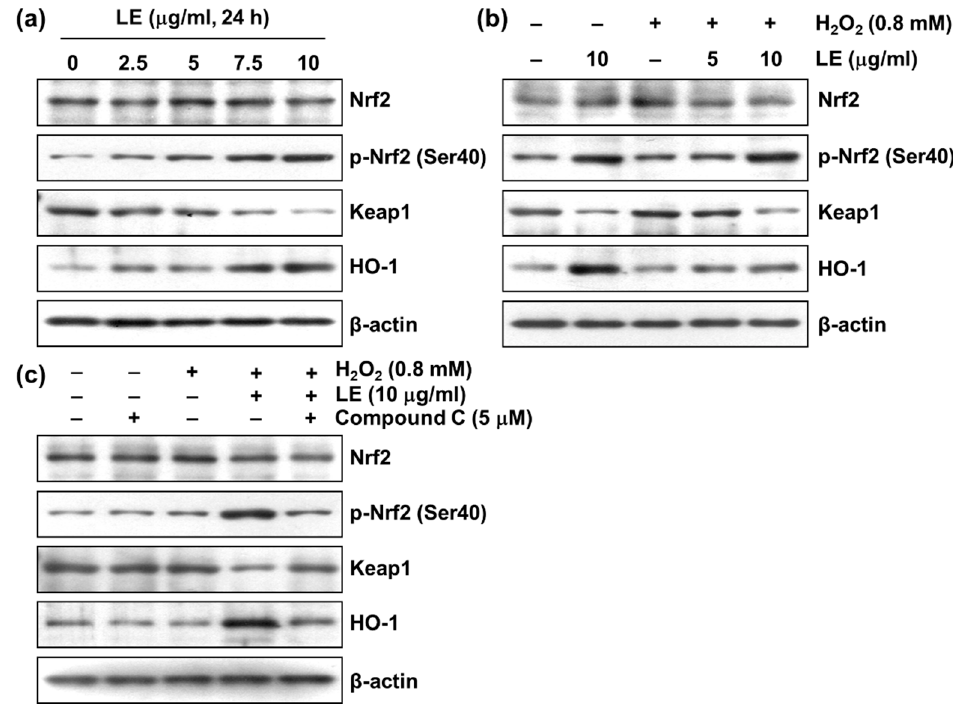
Figure 7. Effect of LE on Nrf2/HO-1 signaling in C2C12 cells: ( a ) Effect of LE on the Nrf2, p-Nrf2 (Ser40), Keap1, and HO-1 levels of total cell lysates. Western blot analysis was performed using β -actin as a loading control. Representative results of three independent experiments are shown; ( b ) Cells were pretreated with LE for 1 h and then stimulated in the presence or absence of 1 mM H 2 O 2 for 24 h. Representative results of three independent experiments are shown. Cellular proteins were prepared and Nrf2, p-Nrf2 (Ser40), Keap1, and HO-1 protein levels analyzed. Western blot analysis was performed using β -actin as a loading control. Representative results from three independent experiments are shown; ( c ) Cells were pretreated with 5 μ M compound C, with or without 10 μ g/mL LE, for 1 h and then treated with 0.8 mM H 2 O 2 for 24 h. Whole-cell lysates were prepared and Nrf2, p-Nrf2 (Ser40), Keap1, and HO-1 expression profiles were confirmed. Western blot analysis was performed using β -actin as a loading control. Representative results from three independent experiments are shown. Nrf2, nuclear factor erythroid 2-related factor 2; Keap1, Kelch-like ECH-associ- ated protein 1; HO-1, heme oxygenase-1.